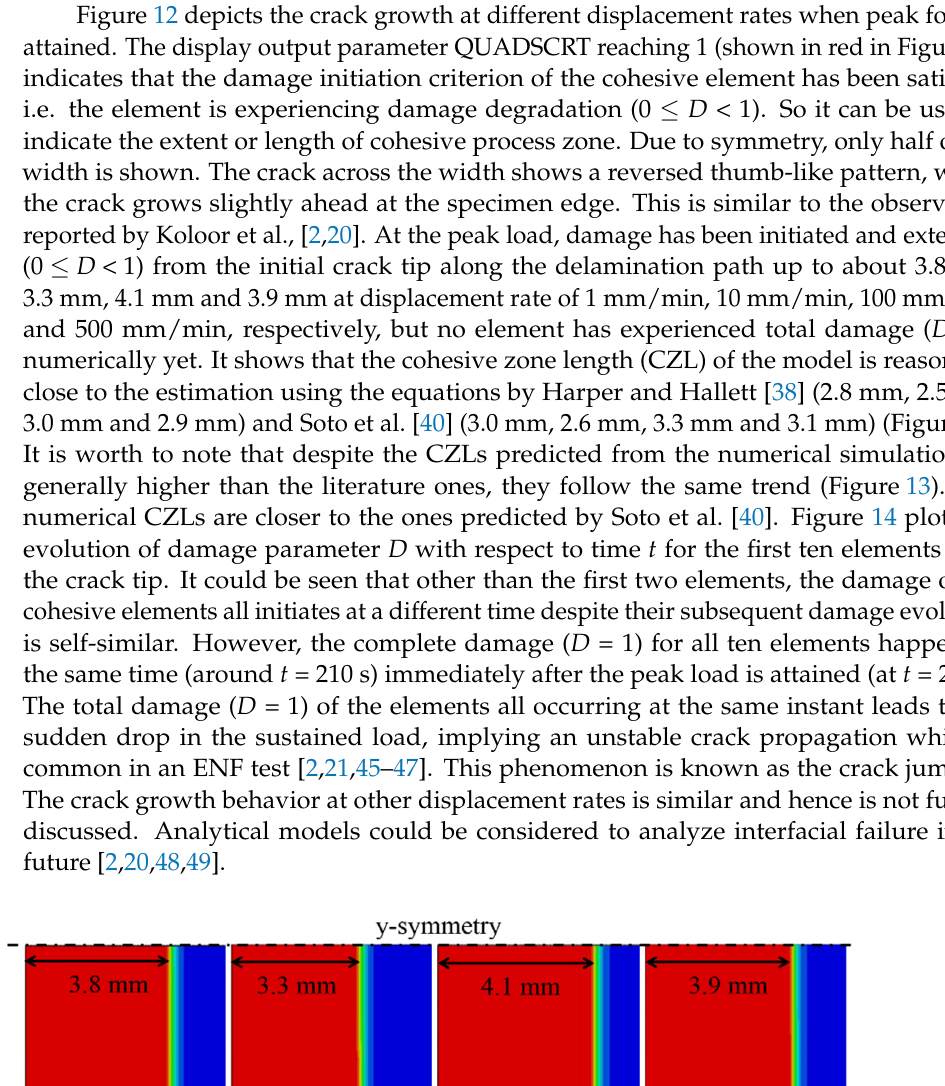
Figure 13. Variation of the cohesive zone length with respect to the displacement rate.